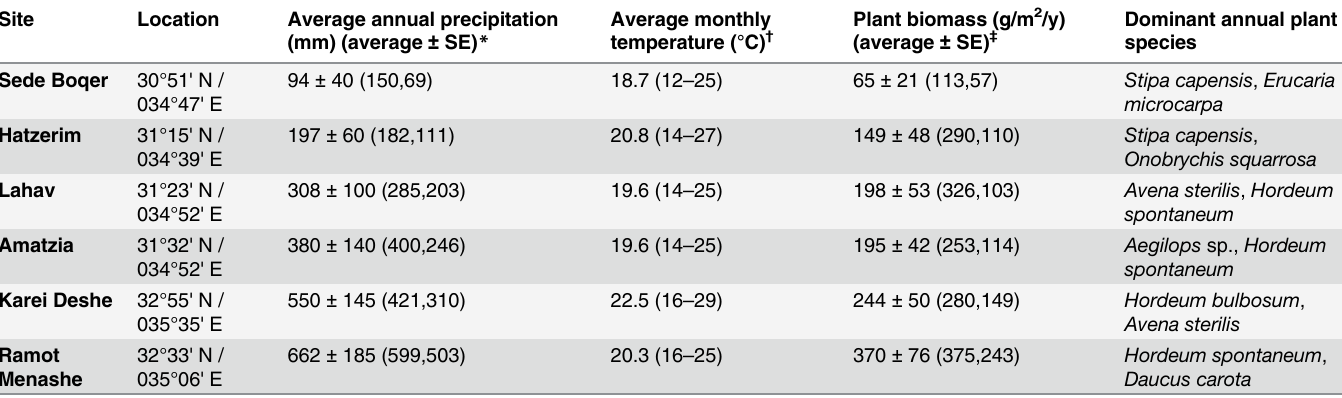
Table 1. Study sites and their